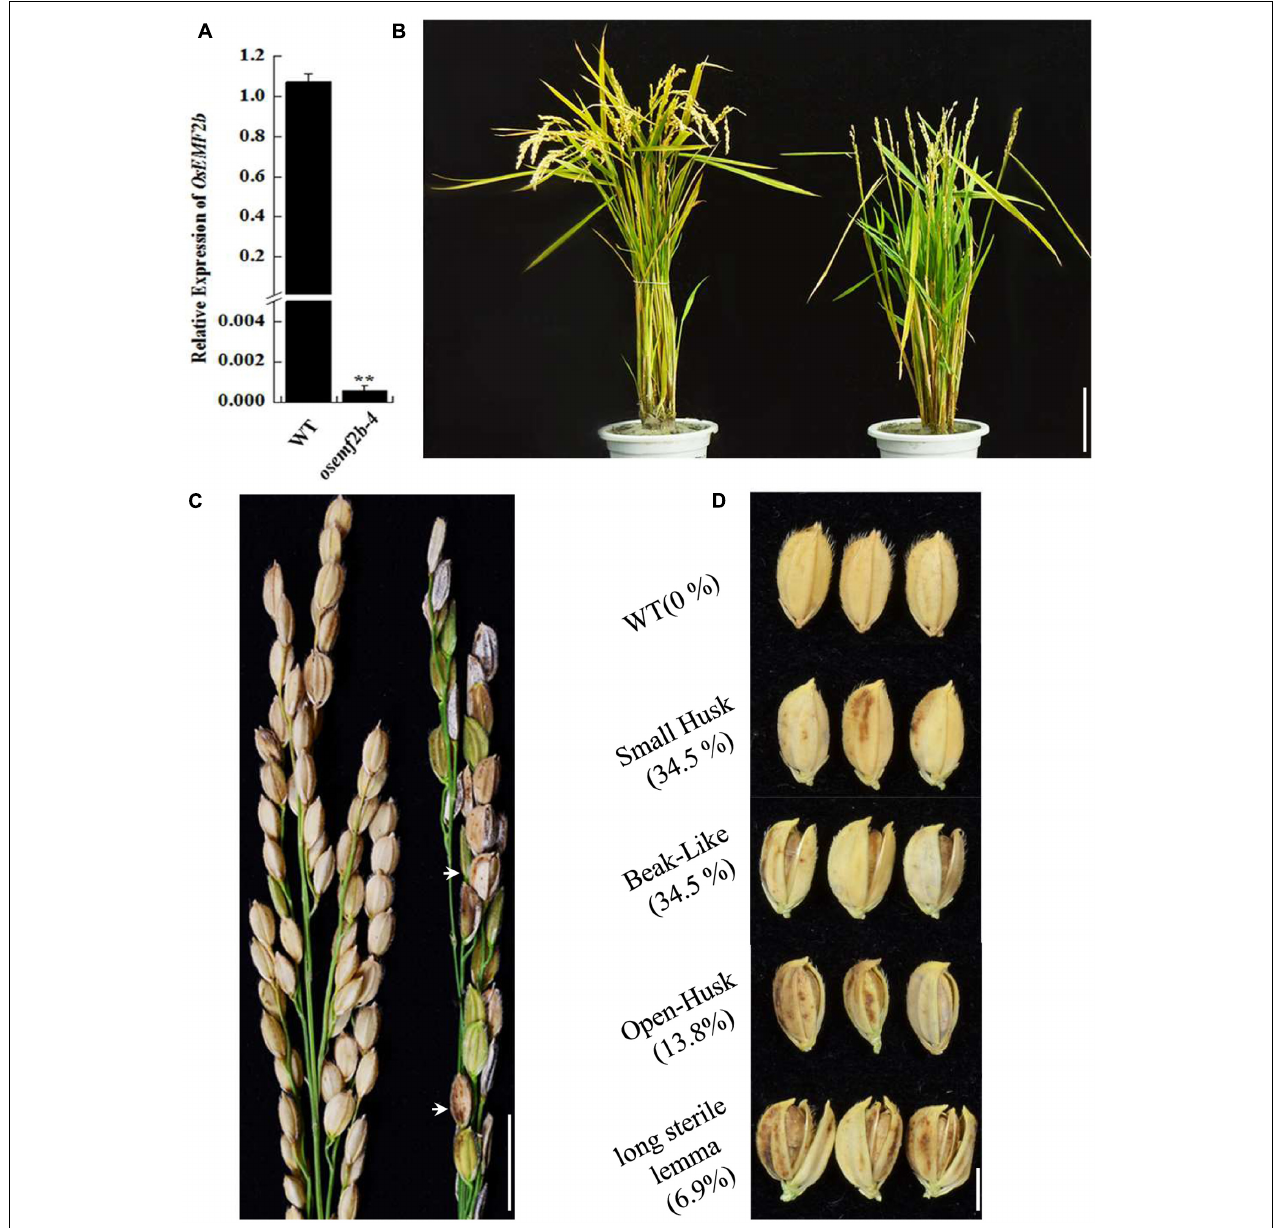
FIGURE 1 | Phenotypic and RT-qPCR analyses of osemf2b-4. (A) Expression levels of OsEMF2b in the WT or osemf2b-4 leaves were detected by RT-qPCR. Error bars indicate SD. ∗∗ indicates significant difference by Student’s t -test ( P ≤ 0.01). (B) Plant phenotypes of wild type (left) and osemf2b-4 (right) at maturity. Bars = 5 cm. (C) Panicles of wild type (left) and osemf2b-4 (right). Abnormal seeds are marked with white arrow in the osemf2b-4 panicle. Data are given as mean ± SEM ( n = 3). Bars = 2 cm. (D) Seed phenotypes of wild type and osemf2b-4 . The numbers to the left were calculated as the proportion of slightly defective types of abnormal seeds to spikelets for each plant at maturity. The 10.3% remaining were sterile spikelets. Bars = 5 mm.